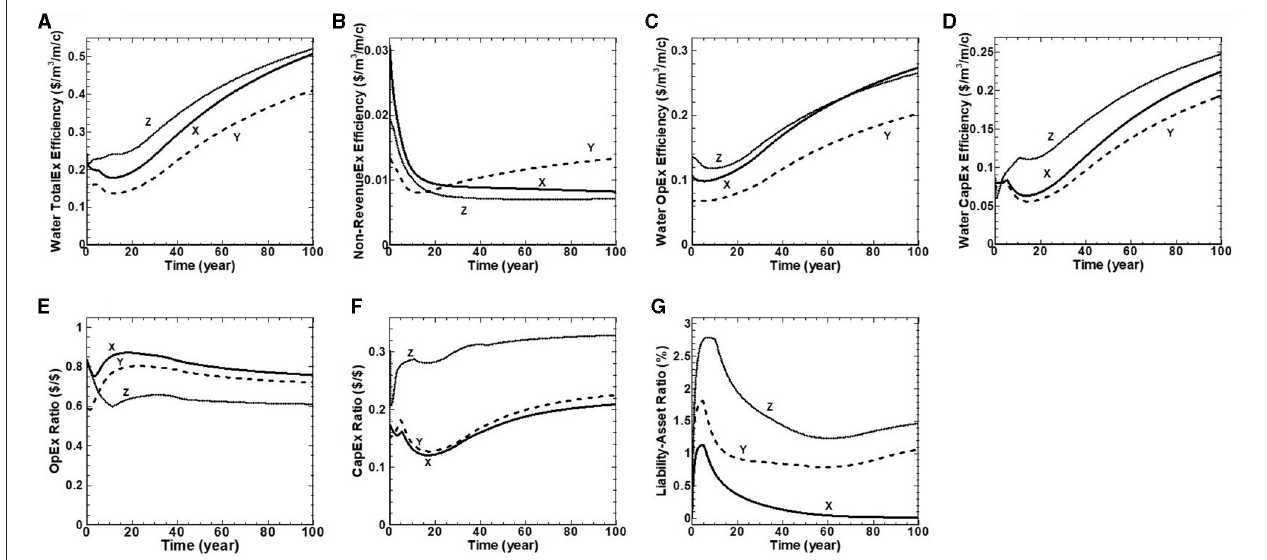
FIGURE 8 | (A–G) Water financial performance indicators over a 100-year benchmarking period for utilities X, Y, and Z.